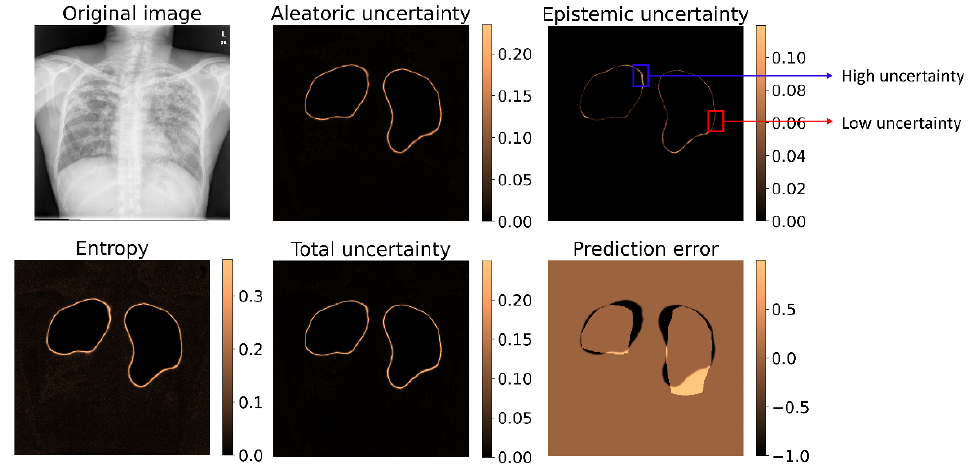
Figure 6. Uncertainty representation using various uncertainty metrics and the prediction error are shown for a sample CXR from the test set. The blue bounding box denotes predicted pixels with high uncertainty, and the red bounding box shows those with low uncertainty.